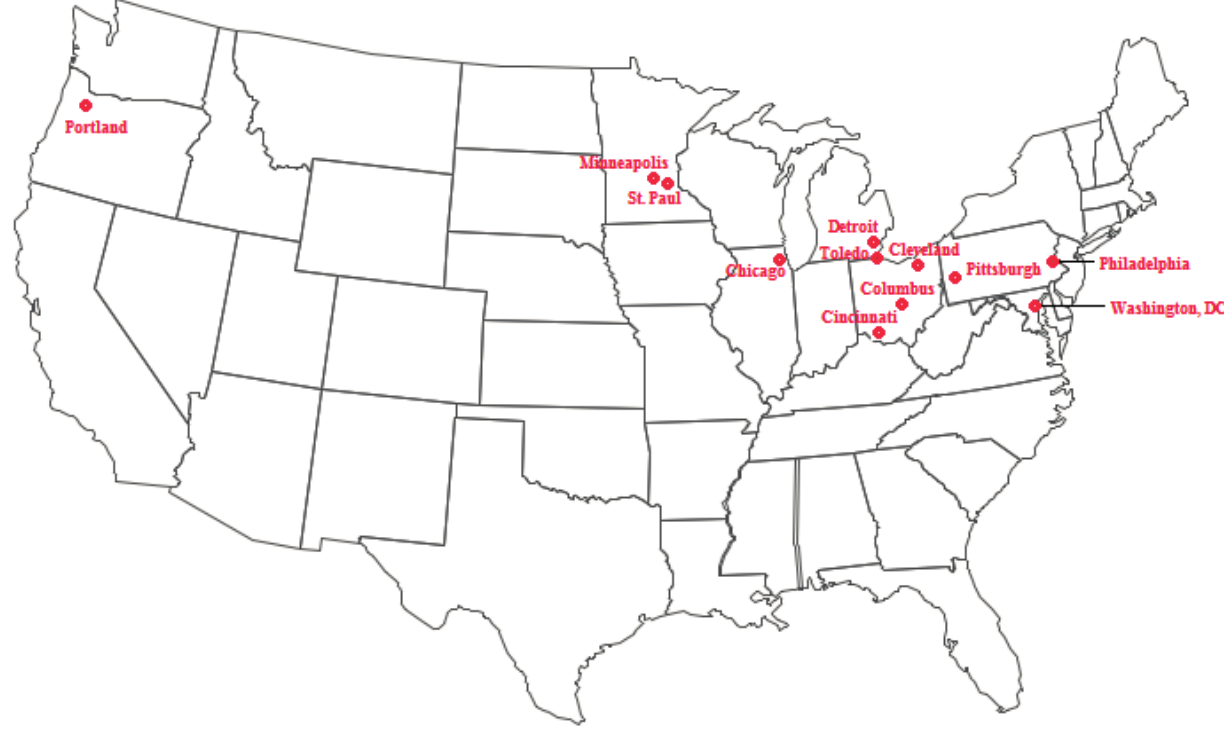
Figure 1. Cities analyzed in the present